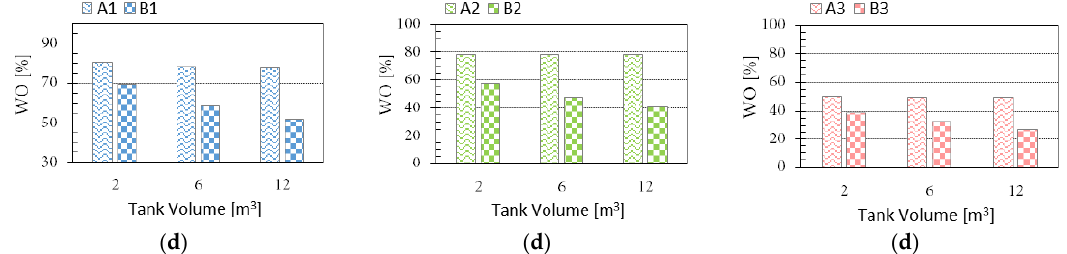
Figure 3. Water saving efficiency ( top ) and wastewater overflow ( bottom ) with respect to three ‐ tank volume (2, 6 and 12 m 3 ) for scenario A1 and B1 ( a , d ), A2 and B2 ( b , e ), A3 and B3 ( c , f )